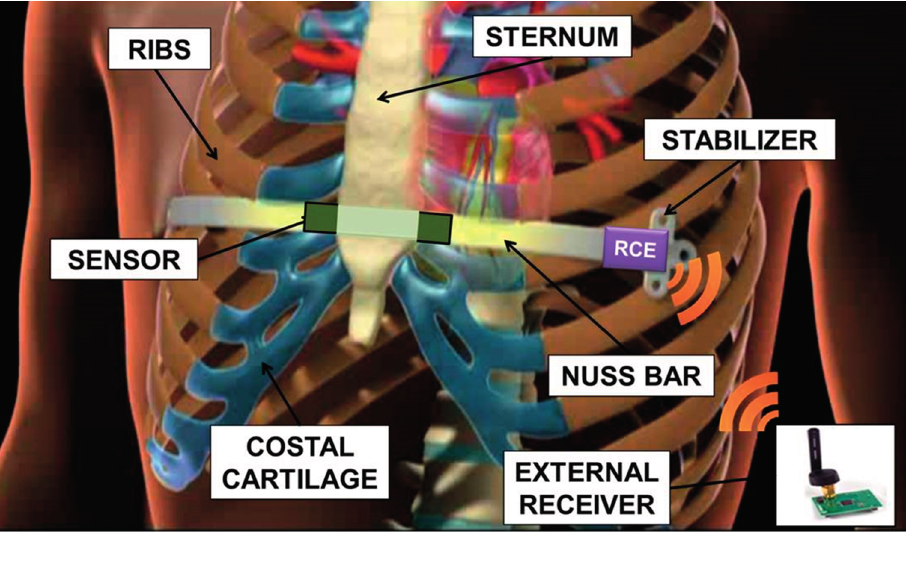
Figure 1. Schematic representation of the sensorized Nuss bar. Remote-controlled electronics allow, through wireless communication, to send the force signal to an external